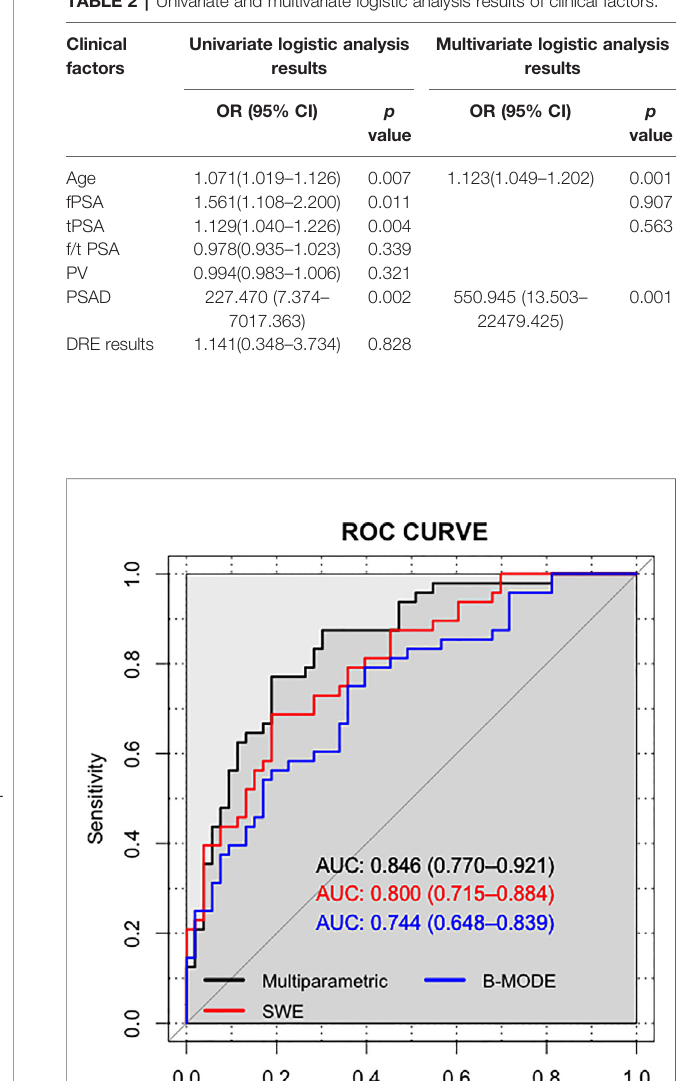
TABLE 2 | Univariate and multivariate logistic analysis results of clinical factors.